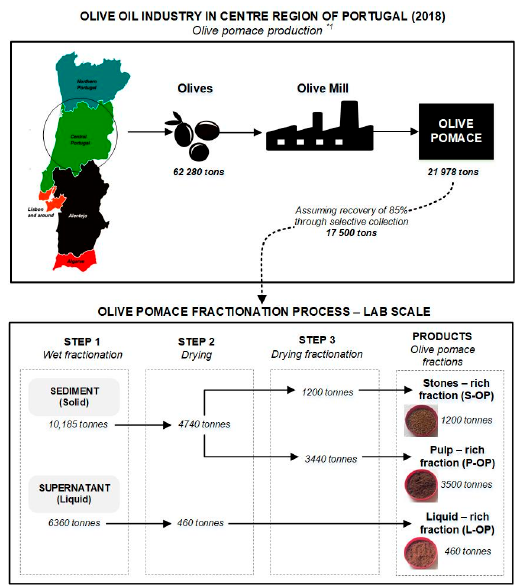
Figure 4. The yield of the fractionation process for olive pomace valorisation of the centre region of Portugal according to estimated production of 2018.